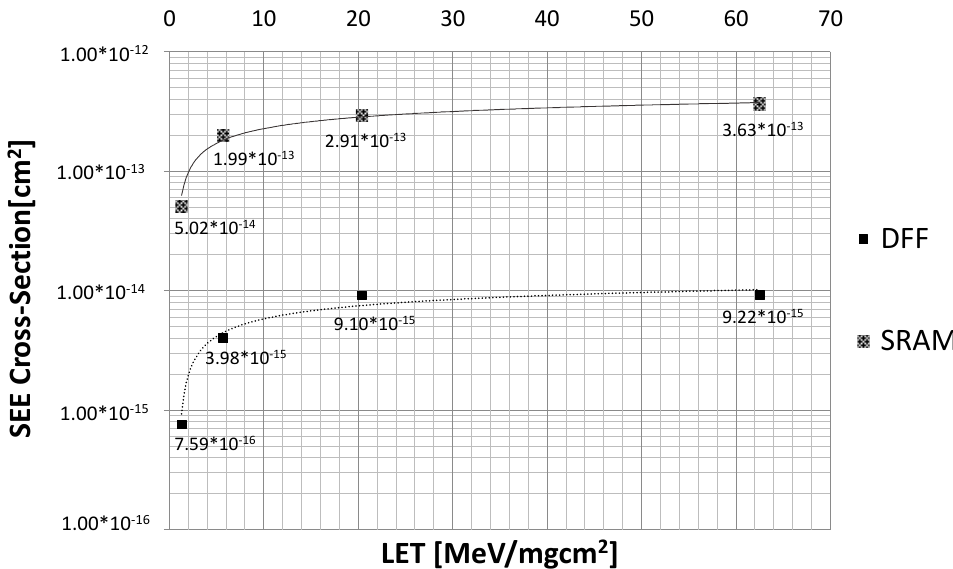
Figure 7. SEE cross-section [cm 2 ] for static radiation analysis of SRAM and FF in 28 nm.